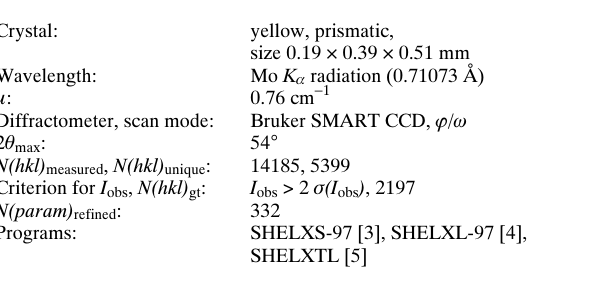
Table 1. Data collection and